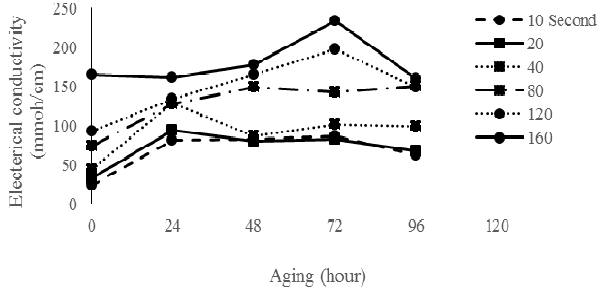
Fig.3. Interaction effects of aging and Ultrasonic assisted seed priming on the membrane integrity of Silybum marianum